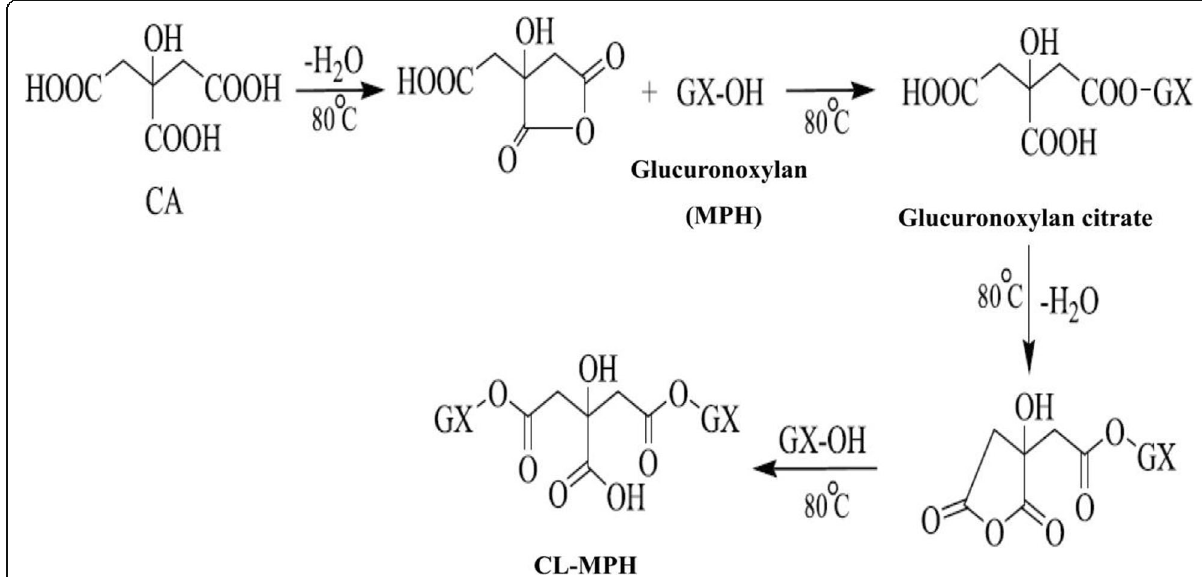
Fig. 5 Synthesis scheme for CL-MPH using CA and MPH. [ “ Reprinted (adapted) with permission from [18]. Copyright 2019 Elsevier. ”